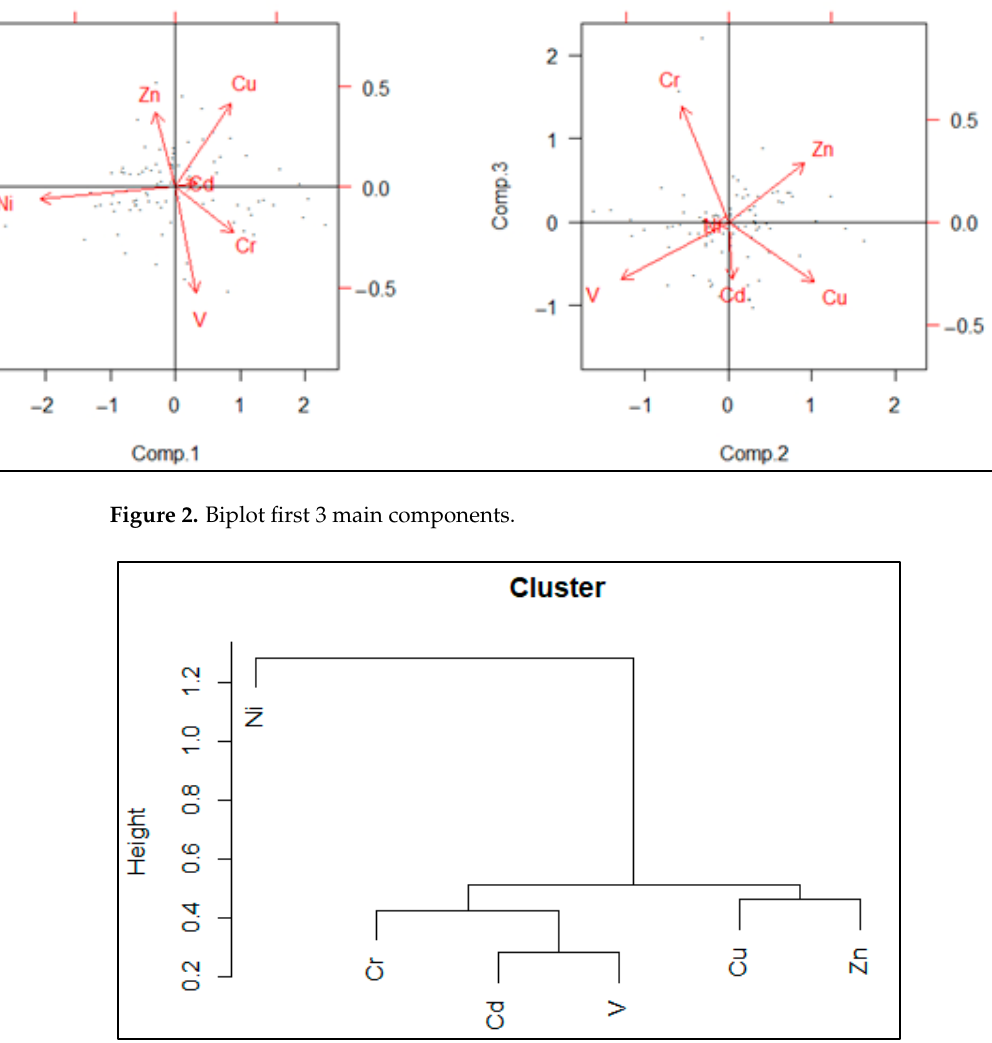
Figure 3. Dendrogram of Cluster analysis of heavy metals.